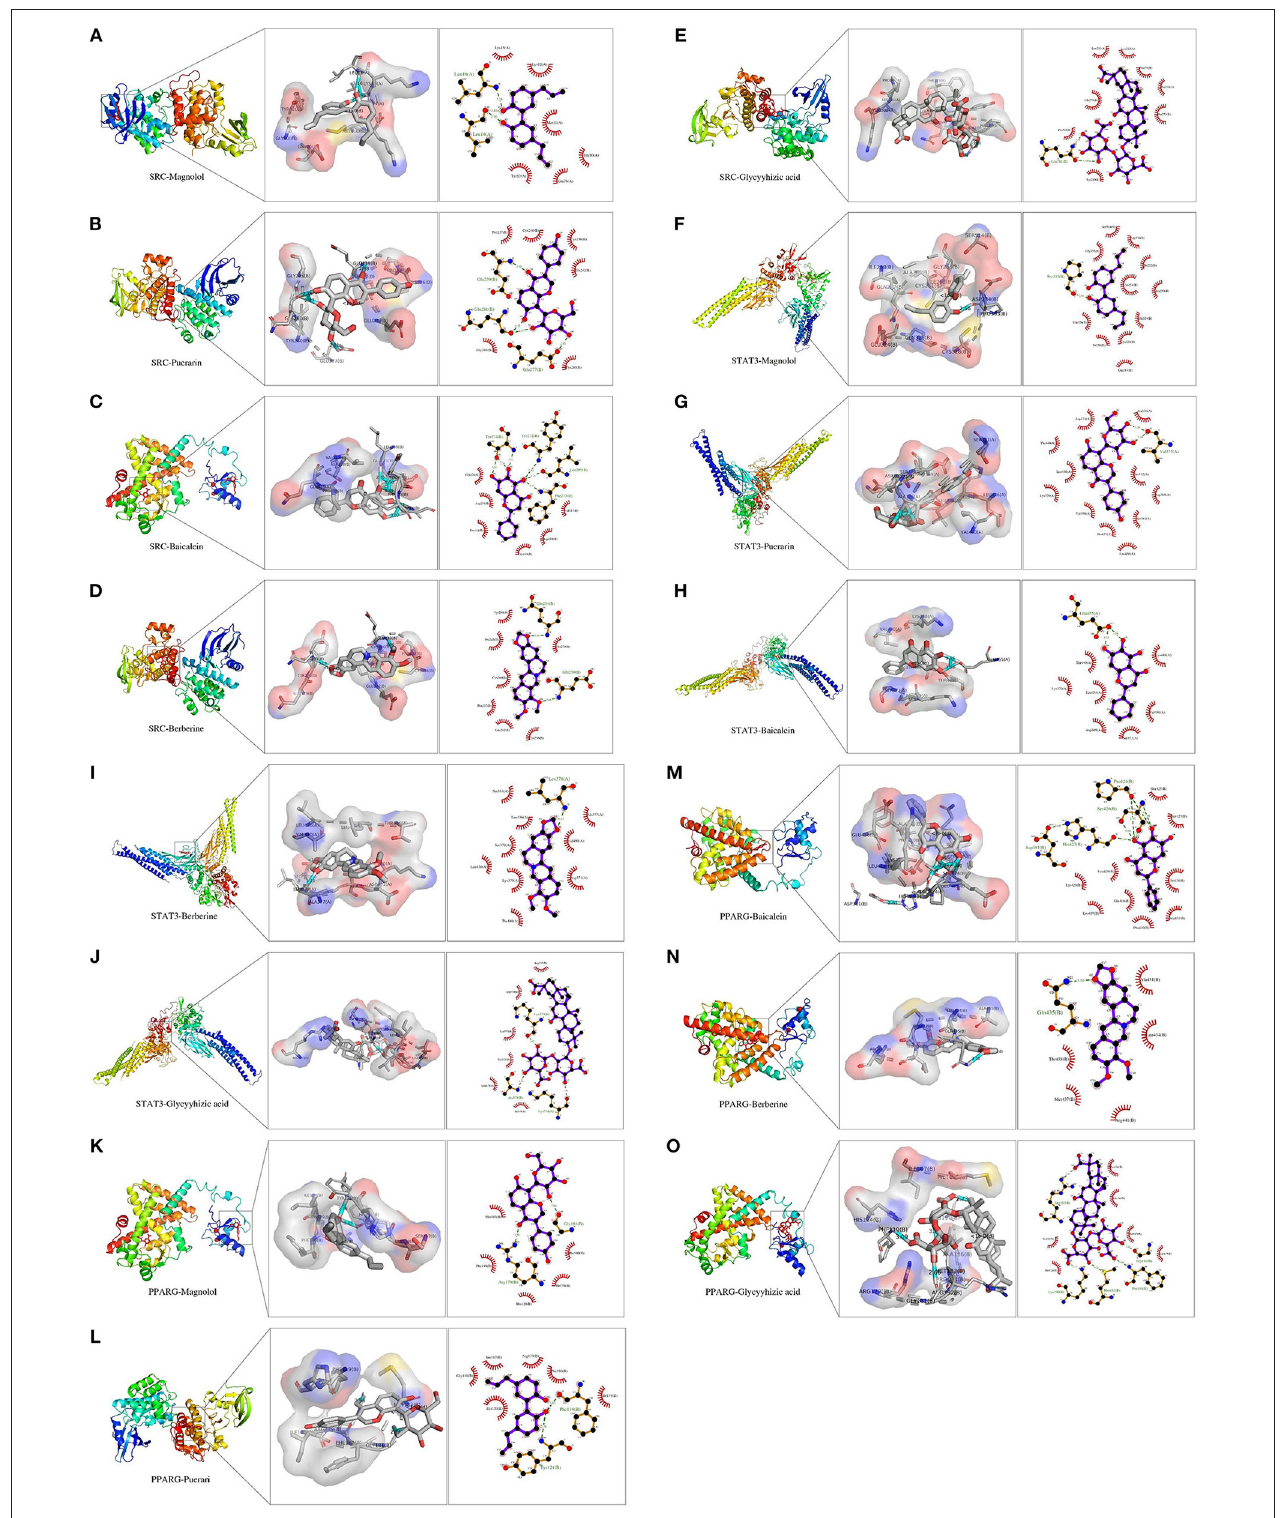
FIGURE 7 | (A–O) Demonstration of molecular docking of drugs and Hubba genes. (A) Demonstration of molecular docking of SRC and Magnolol. (B) Demonstration of molecular docking of SRC and Puerarin. (C) Demonstration of molecular docking of SRC and Baicalein. (D) Demonstration of molecular docking of SRC and Berberine. (E) Demonstration of molecular docking of SRC and Glycyrrhizic acid. (F) Demonstration of molecular docking of STAT3 and